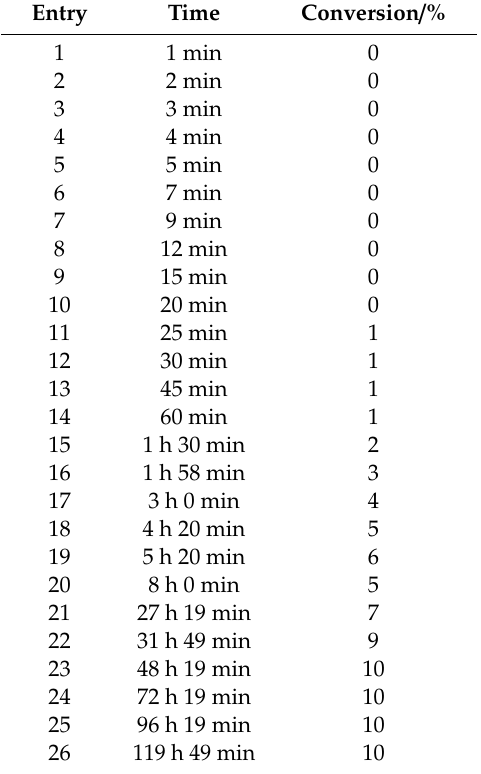
Table A5. Reduction of acetophenone ( 1 ) to 1-phenylethanol ( R )- 2 . Change from standard procedure: dichloromethane (DCM) (solvent).